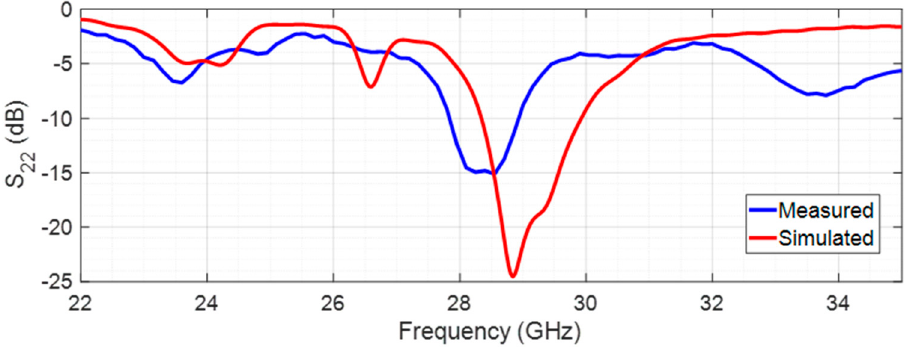
Figure 13. Simulated and measured reflection coefficient of the filtenna in transmission mode.